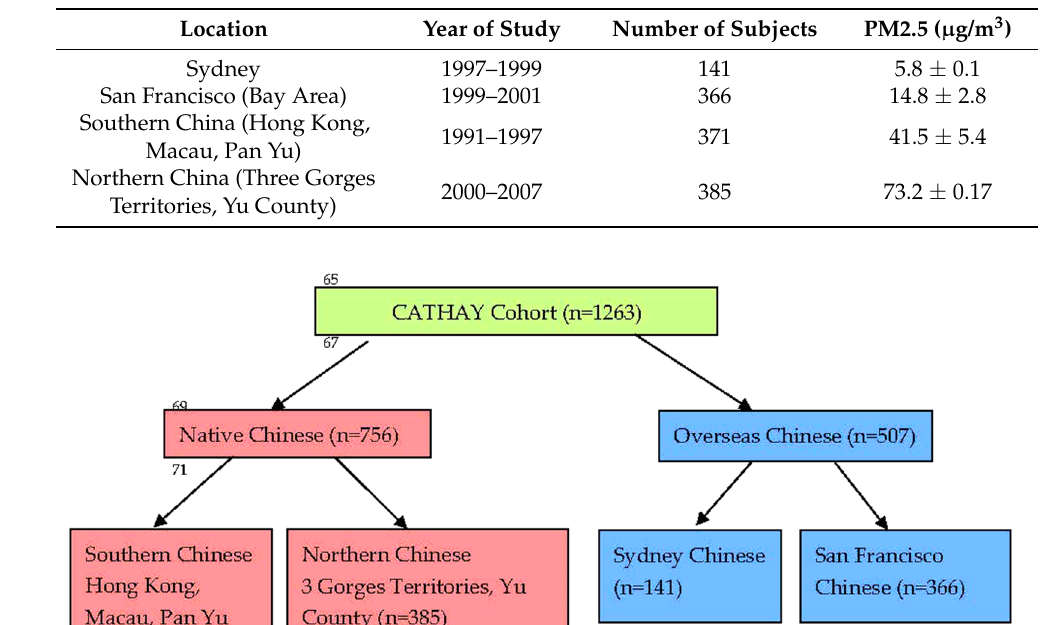
Table 1. Mean yearly PM2.5 air pollution exposure.